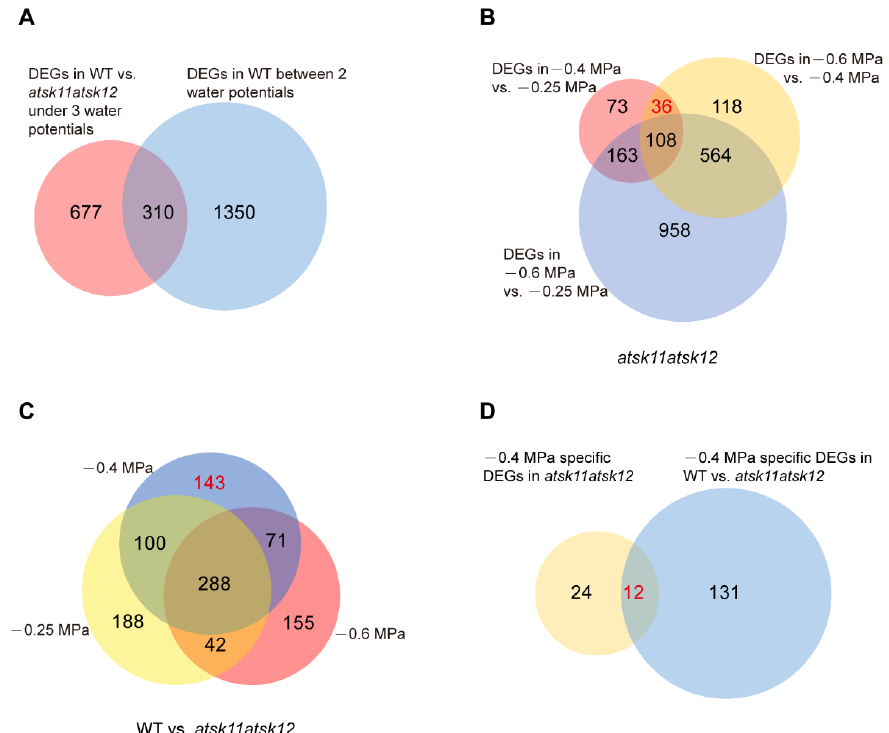
Figure 3. The mild osmotic stress-responsive genes regulated by AtSK11 and AtSK12 were identified through DEG analysis. ( A ) Venn diagram of two sets of DEGs, including all DEGs in WT vs. atsk11atsk12 under three water potentials ( − 0.25 MPa, − 0.4 MPa, and − 0.6 MPa) and all DEGs in WT between two water potentials ( − 0.25 vs. − 0.4 MPa, − 0.4 MPa vs. − 0.6 MPa, − 0.25 MPa vs. − 0.6 MPa). ( B ) Venn diagram of DEGs in atsk11atsk12 between two water potentials. The number of − 0.4 MPa-specific DEGs (36) in atsk11atsk12 is indicated in red. ( C ) Venn diagram of DEGs of WT vs. atsk11atsk12 under three water potentials. The number of − 0.4 MPa-specific DEGs (143) in WT vs. atsk11atsk12 is indicated in red. ( D ) Venn diagram of two sets of genes, including − 0.4 MPa-specific DEGs (36) in atsk11atsk12 and − 0.4 MPa-specific DEGs (143) in WT vs. atsk11atsk12 . The number of − 0.4 MPa-responsive genes is indicated in red. The number of genes in each set is shown in the diagrams.